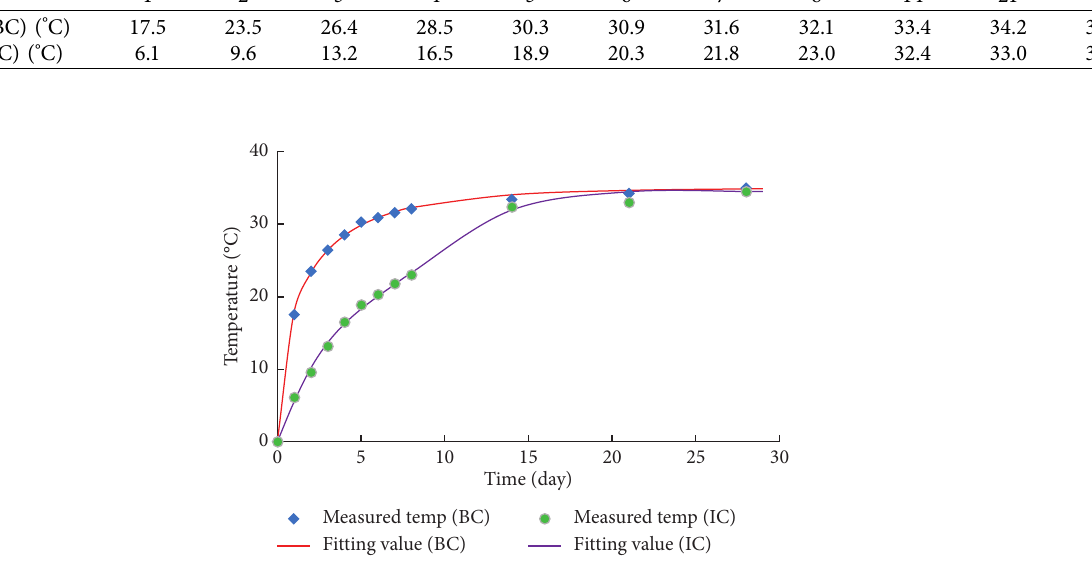
Figure 1: Fitting curve of adiabatic temperature rise of BC and IC. Table 3: Thermodynamic parameters of rock foundation.